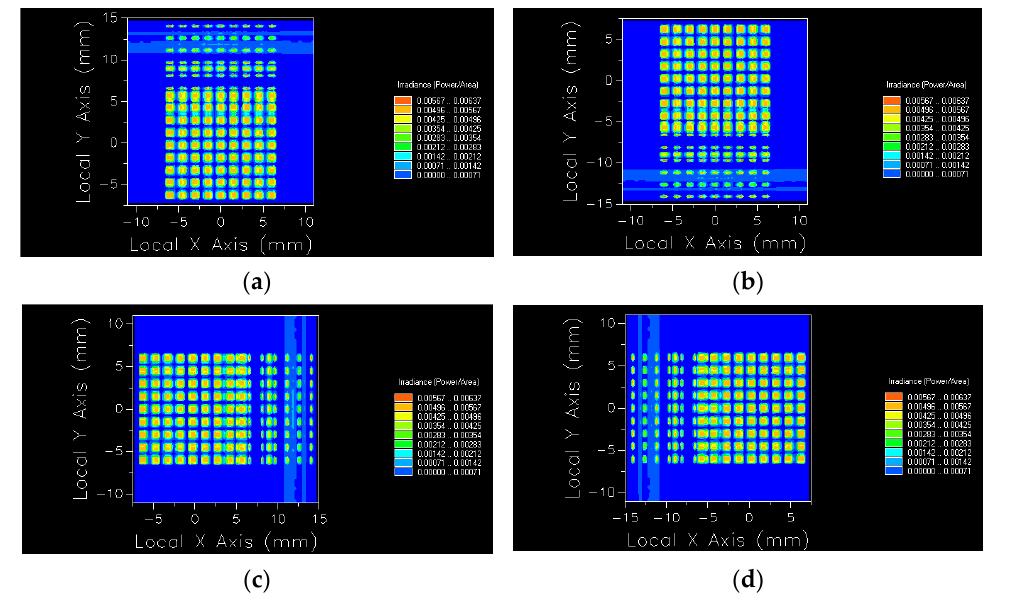
Figure 7. Imaging diagrams under four characteristic situations. ( a ) Y axis, δ = − 2°, θ = − 0.5°, ( b ) Y axis, δ = 2°, θ = 0.5°, ( c ) X axis, δ = − 2°, θ = − 0.5°, ( d ) X axis, δ = 2°, θ = 0.5°. Table 2. Power value (Watts) of each aperture (Y axis, δ = − 2 ◦ , θ = − 0.5 ◦